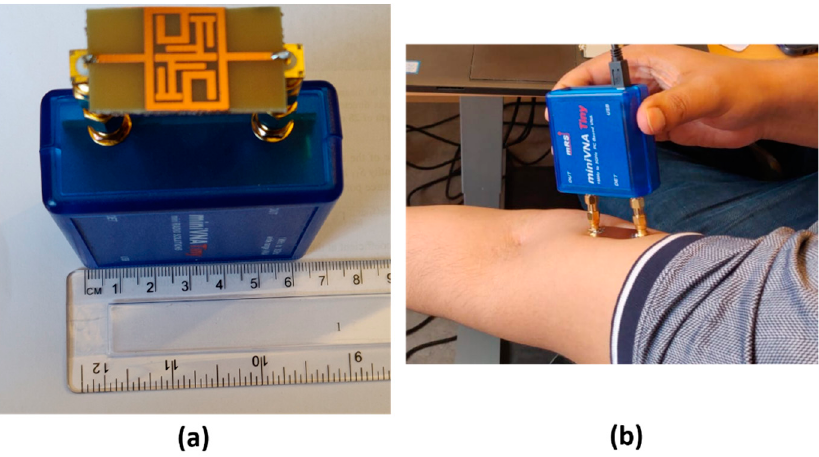
Figure 9. The bandstop sensor without superstrate layer ( a ). The bandstop sensor used in a test b measurement ( b ). measurement (